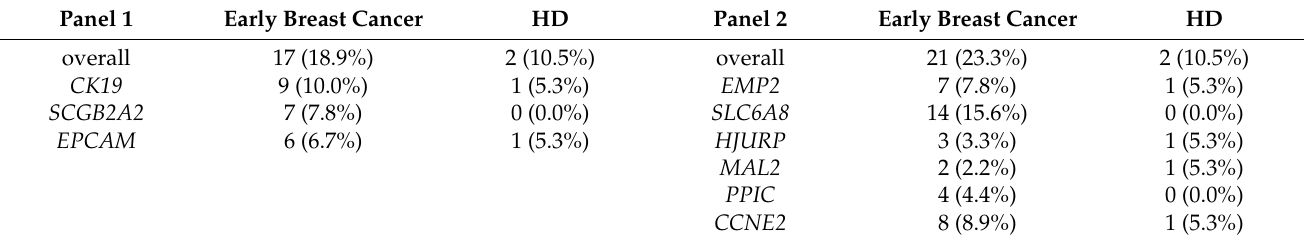
Table 2. Positivity rate of the CTC-related gene markers in early breast cancer patients (n = 90) and healthy donors (HD, n = 19) after applying a cut-off threshold value. The positivity rates are given for each marker individually and overall for Panel 1 and Panel 2. For the definition of a positive patient sample, a threshold was set in order to allow a maximum of 10% positive findings in the HD group.